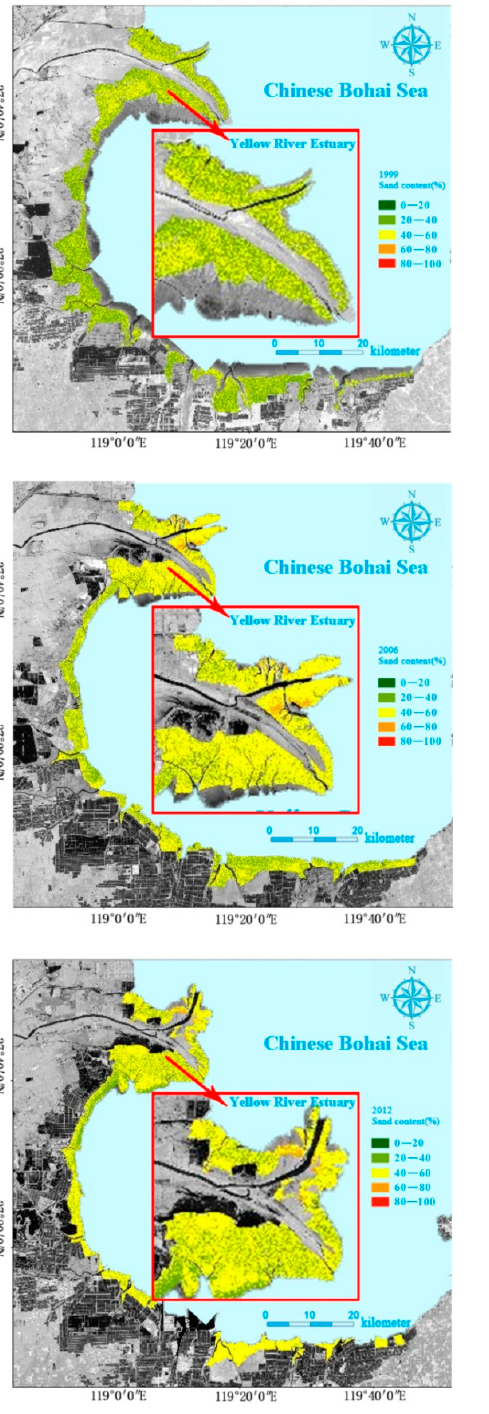
Figure 10. Spatial and temporal distribution of sand content from 1989 to 2015.